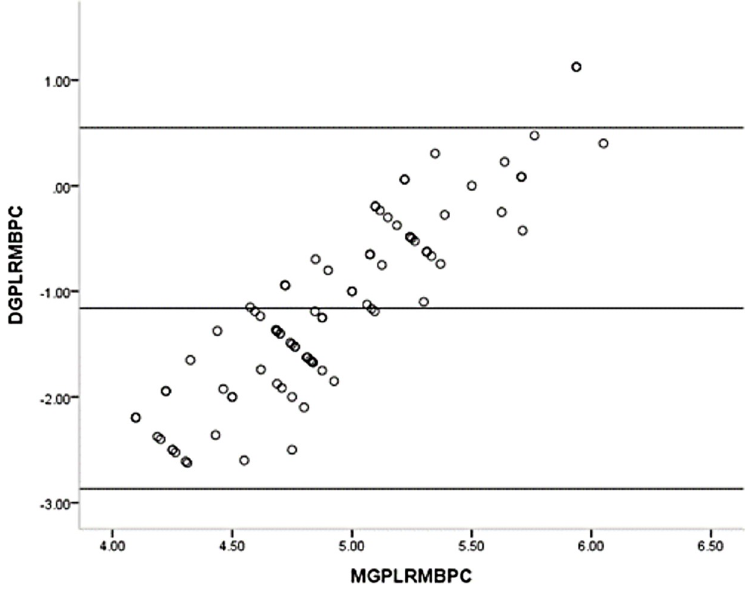
Fig 4. Bland-Altman plot of the GP and the RM before pupillary contraction. GP = general penlight; RM = refractometer; DGPLRMBPDC = difference of general penlight and refractometer before pupillary contraction; MGPLRMBPC = mean of general pen light and refractometer before pupillary